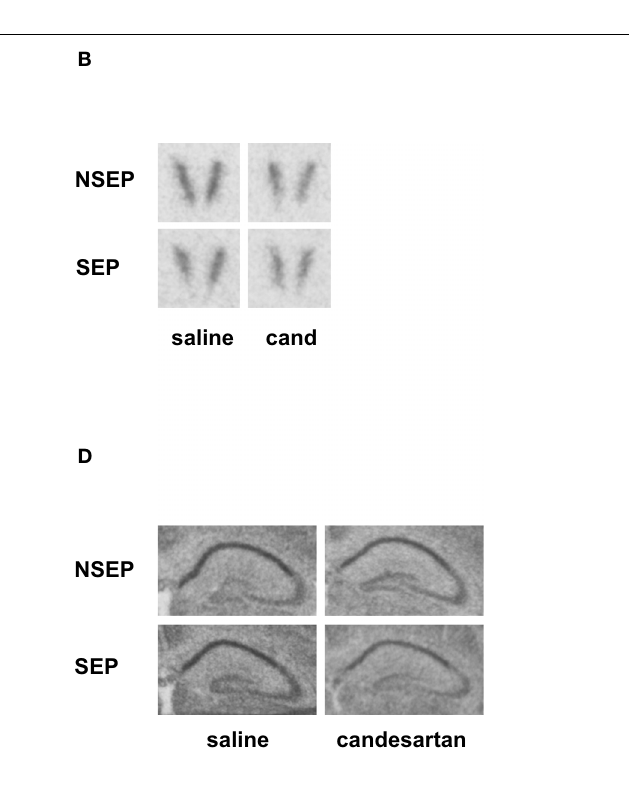
affected by maternal separation or candesartan treatment. However, when combined we observed a signifi cant down-regulation of GR mRNA expression. (B) and (D) : Representative autoradiograms of CRH mRNA expression in the PVN and GR mRNA expression in the hippocampus, respectively. *Signifi cant from NSEP, #signifi cant from vehicle treatment, n = 8 per